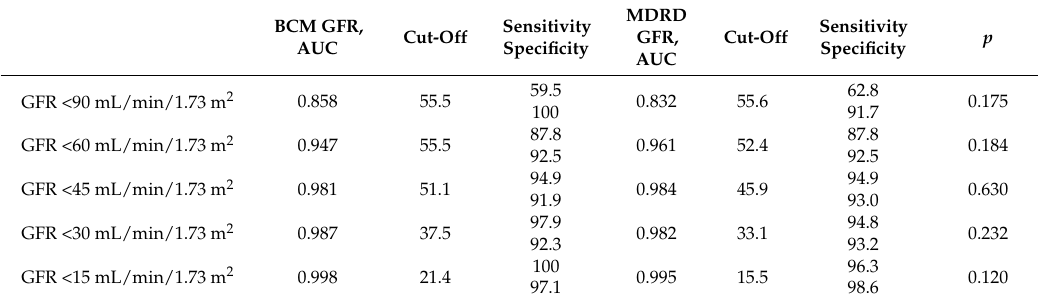
Table 4. Accuracy of the glomerular filtration rate (GFR) predicted from body cell mass (BCM GFR) and with the MDRD formula (MDRD GFR) as indicators of different degrees of GFR impairment. Significance of the differences between the area under the curve (AUC) of the Receiver Operating Characteristics (ROC) plots. MDRD Sensitivity BCM GFR, Sensitivity GFR, Cut-Off Cut-Off Specificity Specificity AUC AUC